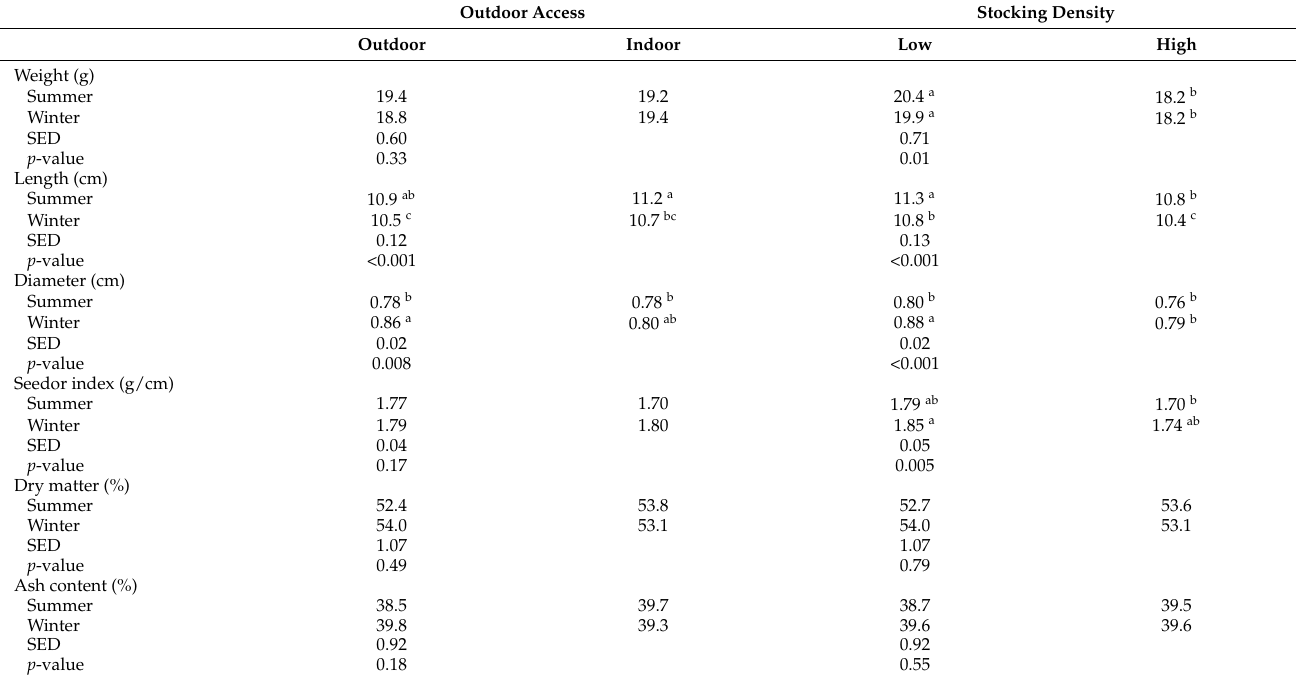
Table 12. Effects of season × system and season × density interactions on the tibia bone properties of Cobb500